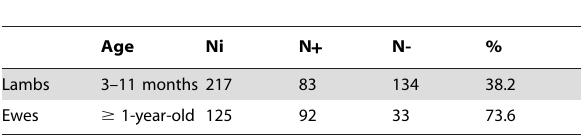
Table 1 . Summary of antibodies prevalence.